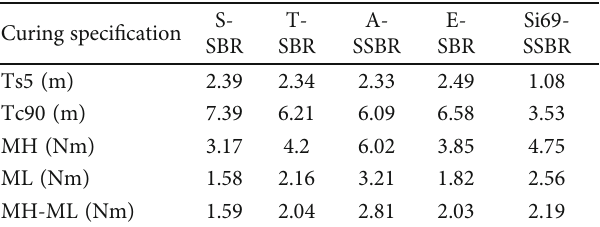
Table 6: Curing speci fi cations of the